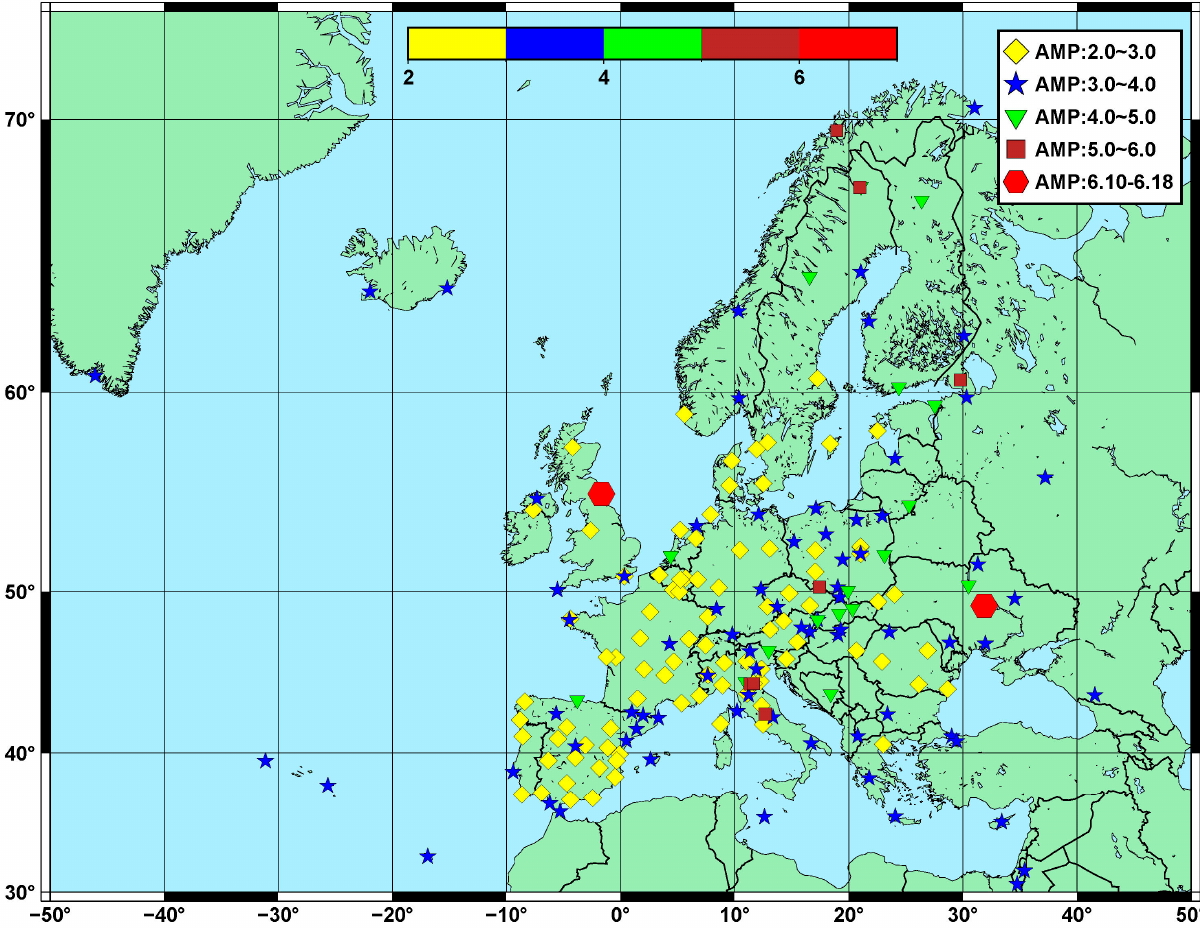
Figure 6. Noise amplitude for the North component.